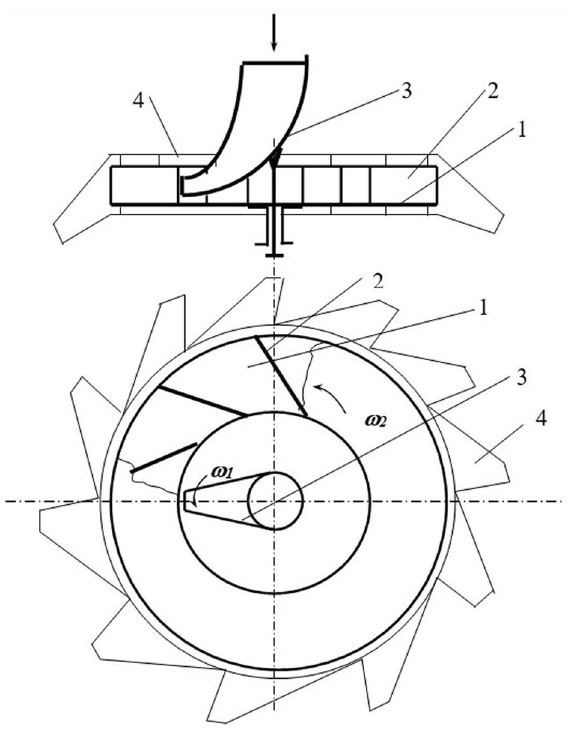
Figure 8. Scheme of the experimental plant. Source: author’s